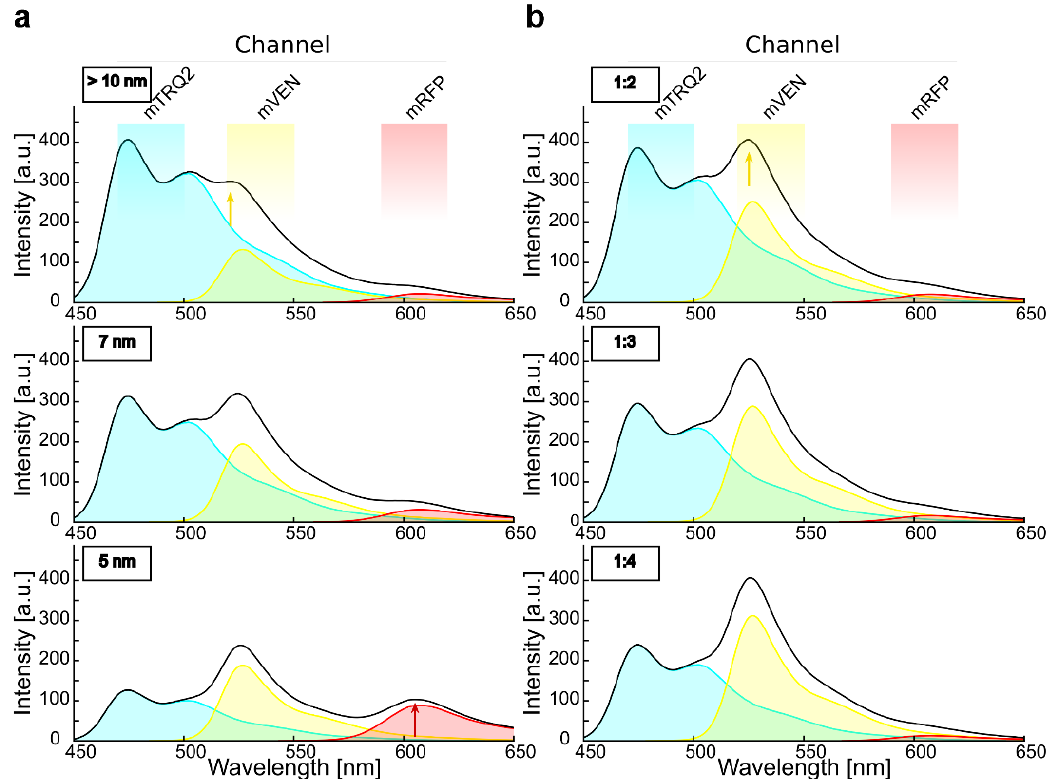
Figure 2. Simulation of emission spectra reveals the crucial impact of relative fluorophore quantities for intensity-based spectral FRET in a three-chromophore arrangement. ( a ) Simulation of the spectra that result from excitation of mTRQ2 with 458 nm for a mTRQ2/mVEN/mRFP stoichiometry of 1:1:1 and in a linear arrangement while placing mVEN at an equal distance from the other two fluorophores. The emission spectra of mTRQ (blue area), mVEN (yellow area) and mRFP (red area) and their combined spectrum (black line) are calculated. The respective emission detector channels are depicted above the plots. With inter-fluorophore distances larger than 10 nm, FRET is negligible ( top ), but cross-excitation of mVEN (yellow arrow) is apparent. For inter-fluorophore distances of 7 nm ( middle ) and 5 nm ( bottom ), FRET lowers the emission intensity of mTRQ2, while the intensity peaks increases around the emission of mVEN at 525 nm and of mRFP at about 610 nm (red arrow) increase. ( b ) Spectra simulation as in a , but without consideration of FRET, calculated for different mTRQ2/mVEN fluorophore ratios. With rising mTRQ2/mVEN ratios of 1:2 ( top ), 1:3 ( middle ) and 1:4 ( bottom ), the intensity peak of mVEN (yellow arrow) increases. Thus, a mTRQ2/mVEN ratio of 1:2 ( b , top) results in a similar spectral shape than with equimolar fluorophores subjected to FRET at a distance of 7 nm ( a , middle).